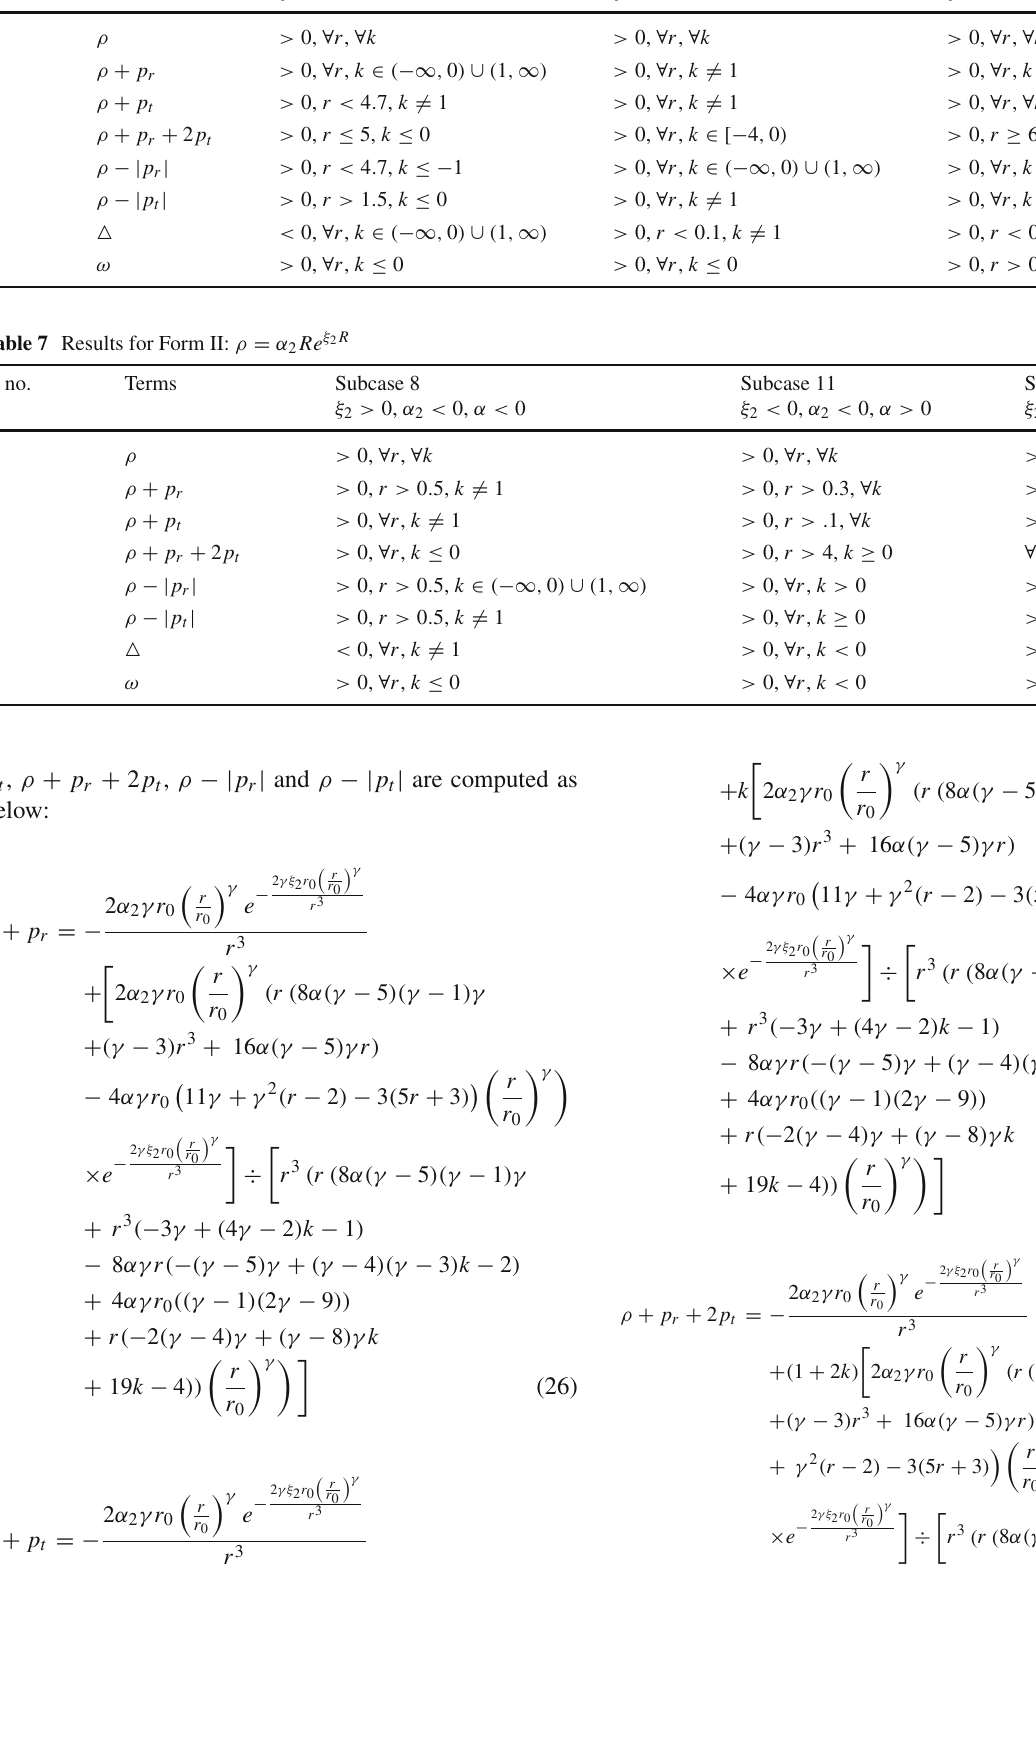
Table 6 Results for Form II: ρ = α 2 Re ξ 2 R S. no.